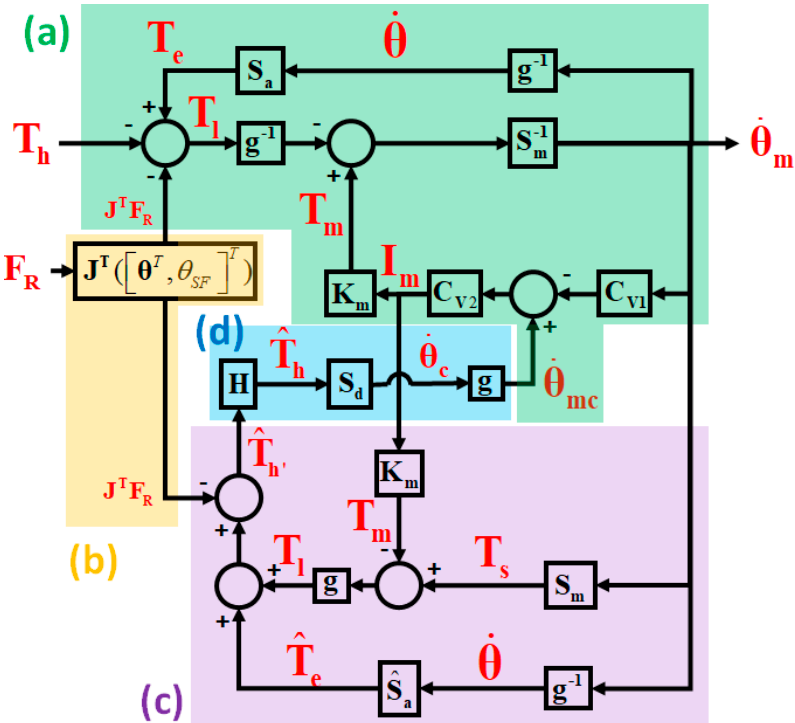
Figure 4. Block diagram of the single-leg exoskeleton control system; ( a ) integrated dynamics including motors, drivers and the exoskeleton mechanism; ( b ) ground reaction force (GRF) compensator; ( c ) admittance law; and ( d ) disturbance observer.